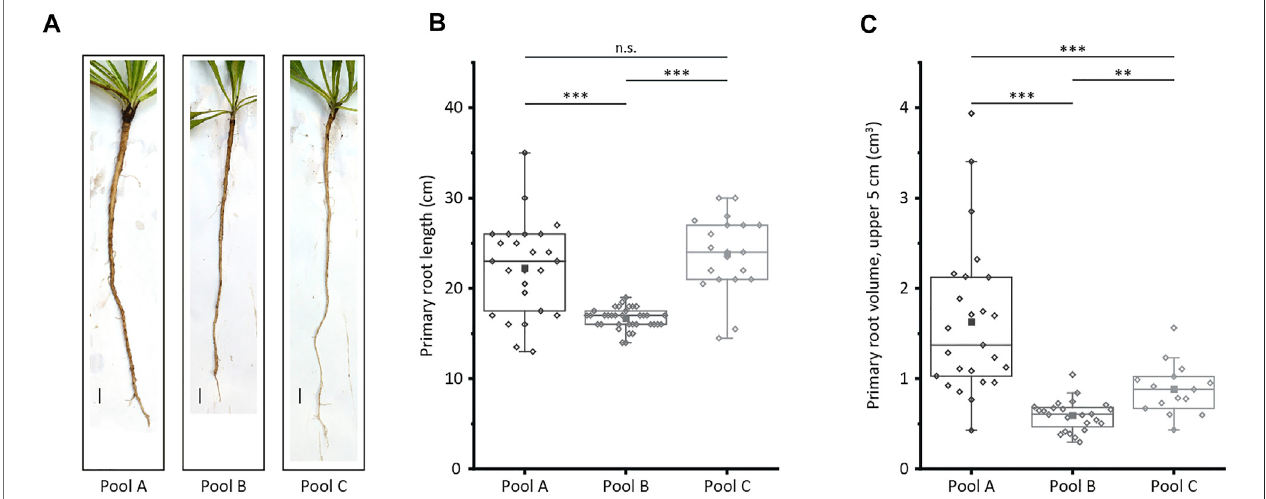
FIGURE 1 | Characterization of the three plant pools selected for MACE. The primary root length and the volume of the upper 5 cm of the root in 12-week-old T. koksaghyz wild-type plants were determined after harvesting. The plants were then assigned to three plant pools (A) Pictures of plants representing the three pools. Scalebar (cid:1) 1 cm (B) Primaryrootlength (C) Volumeoftheupper5 cmoftheprimaryroot,determinedbymeasuringtherootdiameterimmediatelybelowtheleafrosette and 5 cm furtherdown.The boxes delimit valuesfrom the 25th tothe 75th percentile ofeach dataset,the horizontal lineinthe box representsthe median, the fi lled squarerepresentsthe mean, and thelower and upper whiskers represent values that differleast from 25th percentile – 1.5*IQR or 75th percentile +1.5*IQR, respectively (n (cid:1) 15 – 35plants,normaldistributioncon fi rmedusingtheKolmogorov-Smirnovtest,statisticalsigni fi cancecon fi rmedusingatwo-tailed t -test;n.s (cid:1) notsigni fi cant;* p < 0.05; ** p < 0.01; *** p <